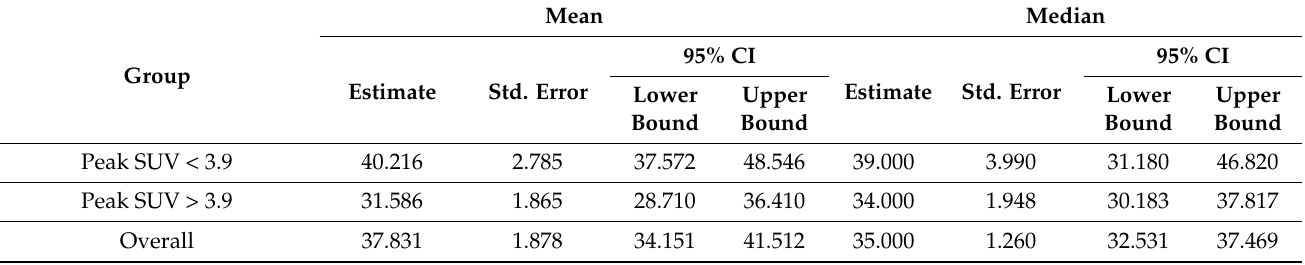
Figure 6. The overall survival in relation to the glycolytic activity. Table 5. Survival time means and medians. Table 6. Survival time means and medians